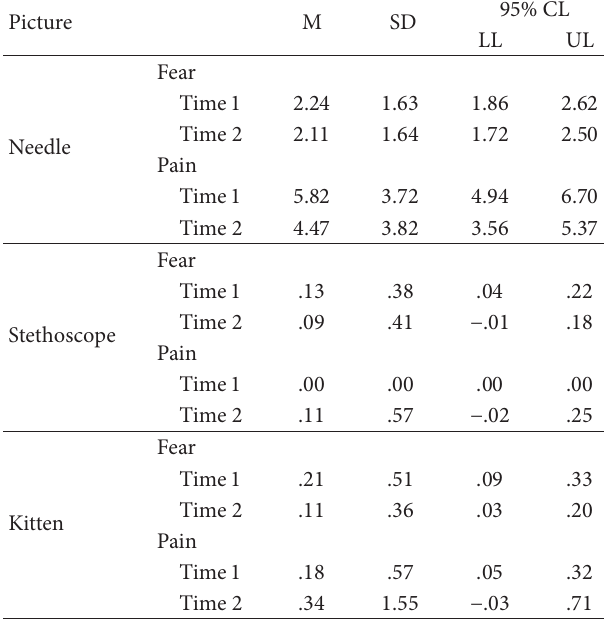
Table 1: Mean fear ratings (CFS, scale of 0–4) and mean pain ratings (FPS-R, scale of 0–10) for picture stimuli at Time 1 and Time 2. Picture